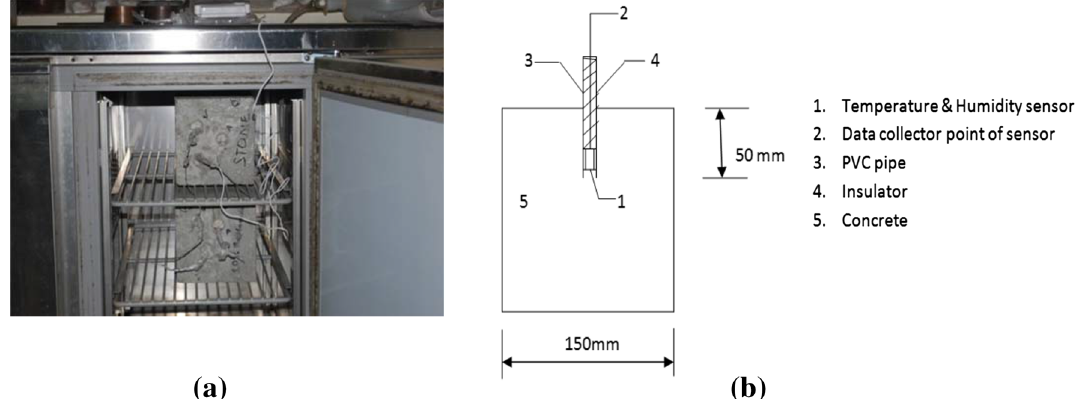
Fig. 10 Internal RH measurement a experimental diagram b schematic diagram.